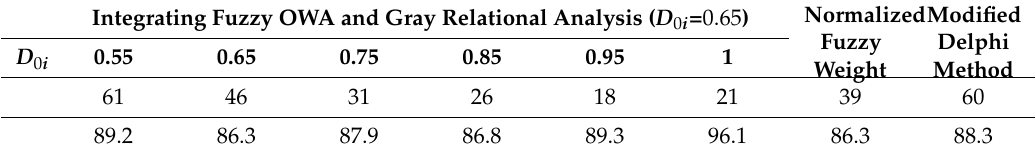
Table 3. Comparison of the second experimental result.